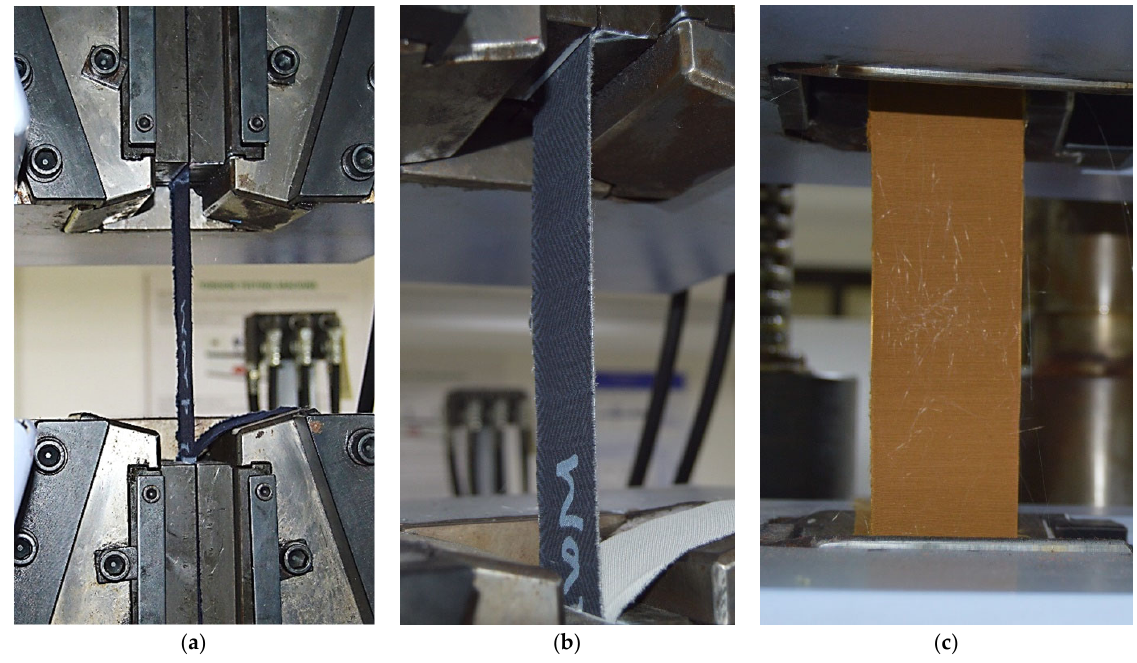
Figure 5. Testing setup for tensile testing of textile fabrics ( a ) TF6 ( b ) TF6 ( c ) TF13. The dimensions of the upper and lower jaws of the UTM grip were 75 × 75 mm. The specimen was first placed in the upper jaws, with folding of the specimen on the other side of jaws, and a steel bar of 10 mm diameter was inserted in the folding to avoid slip ‐ page of specimens within the jaws. The same procedure was adopted with lower jaws as well. After placement of the specimen, gauge length was checked and we initiated the test. Observations of applied load and deflection were noted. Load was continuously applied until rupture of the test specimen. Textile ‐ reinforced mortar (TRM) strips of size 600 × 60 × 10 mm incorporating various types of textile fabrics were prepared. Sixteen types of TRM specimens were prepared for each type of textile fabric sample. Three specimens were casted for each fabric type. Ac ‐ cording to mixture design (Table 3), the mortar mixture was prepared. Oiling of the molds was done in which the TRM was to be casted. The first layer (around 5 mm) of mortar was poured with the help of a spatula (Figure 6a). After leveling the mortar, textile fabric was placed over that layer of mortar in the mold (Figure 6b). The placement of the fabric strip over mortar was carefully handled to prevent the disturbance of mortar thickness. After placing and leveling, a second layer of mortar was poured (Figure 6c). After two days, TRM specimens were taken out from their respective molds (Figure 6d) and placed in water for curing until testing age. A similar casting procedure for TRM was also reported in a previous study [36]. Before testing, the ends of the casted TRM specimen were prepared (Figure 7a). Rub ‐ ber pads of size 100 × 70 × 4 mm were prepared and glued over the ends of the specimen on both sides. These rubber pads prevented local failure within the grips and applied the pressure uniformly over the area. The specimen was first placed in the upper jaws of the UTM and then in the lower jaws. After placement of the specimen into the jaws, the test was started and observations were noted for loads and deflections. Figure 7b shows the placement of the TRM specimen in the UTM for testing purposes.